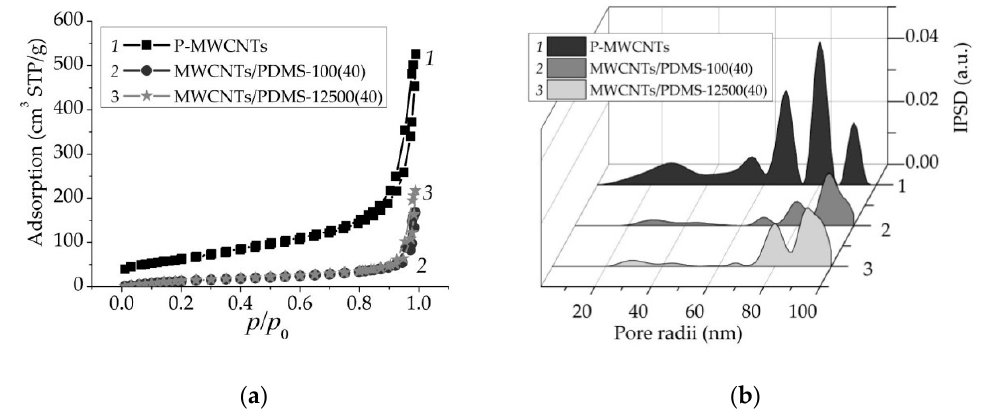
Table 1. Textural characteristics of P-MWCNTs and MWCNTs/PDMS nanocomposites. Sample